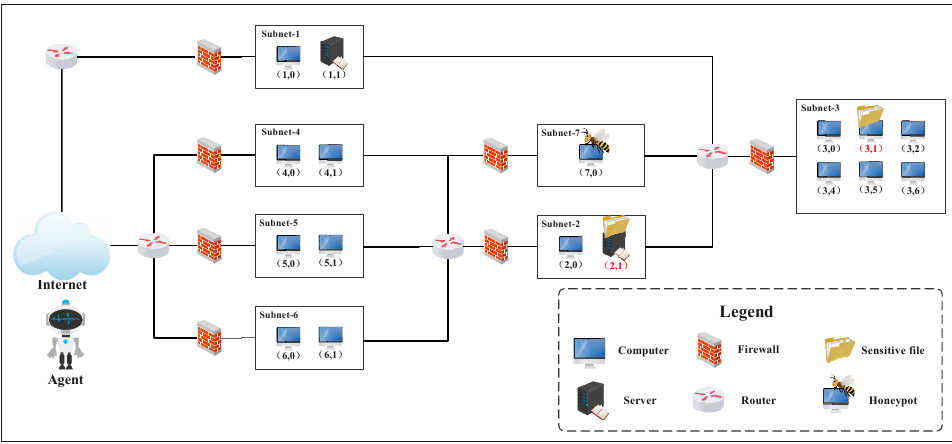
Figure 3. Structure of experimental scenario 1. Sensitive hosts are marked in red